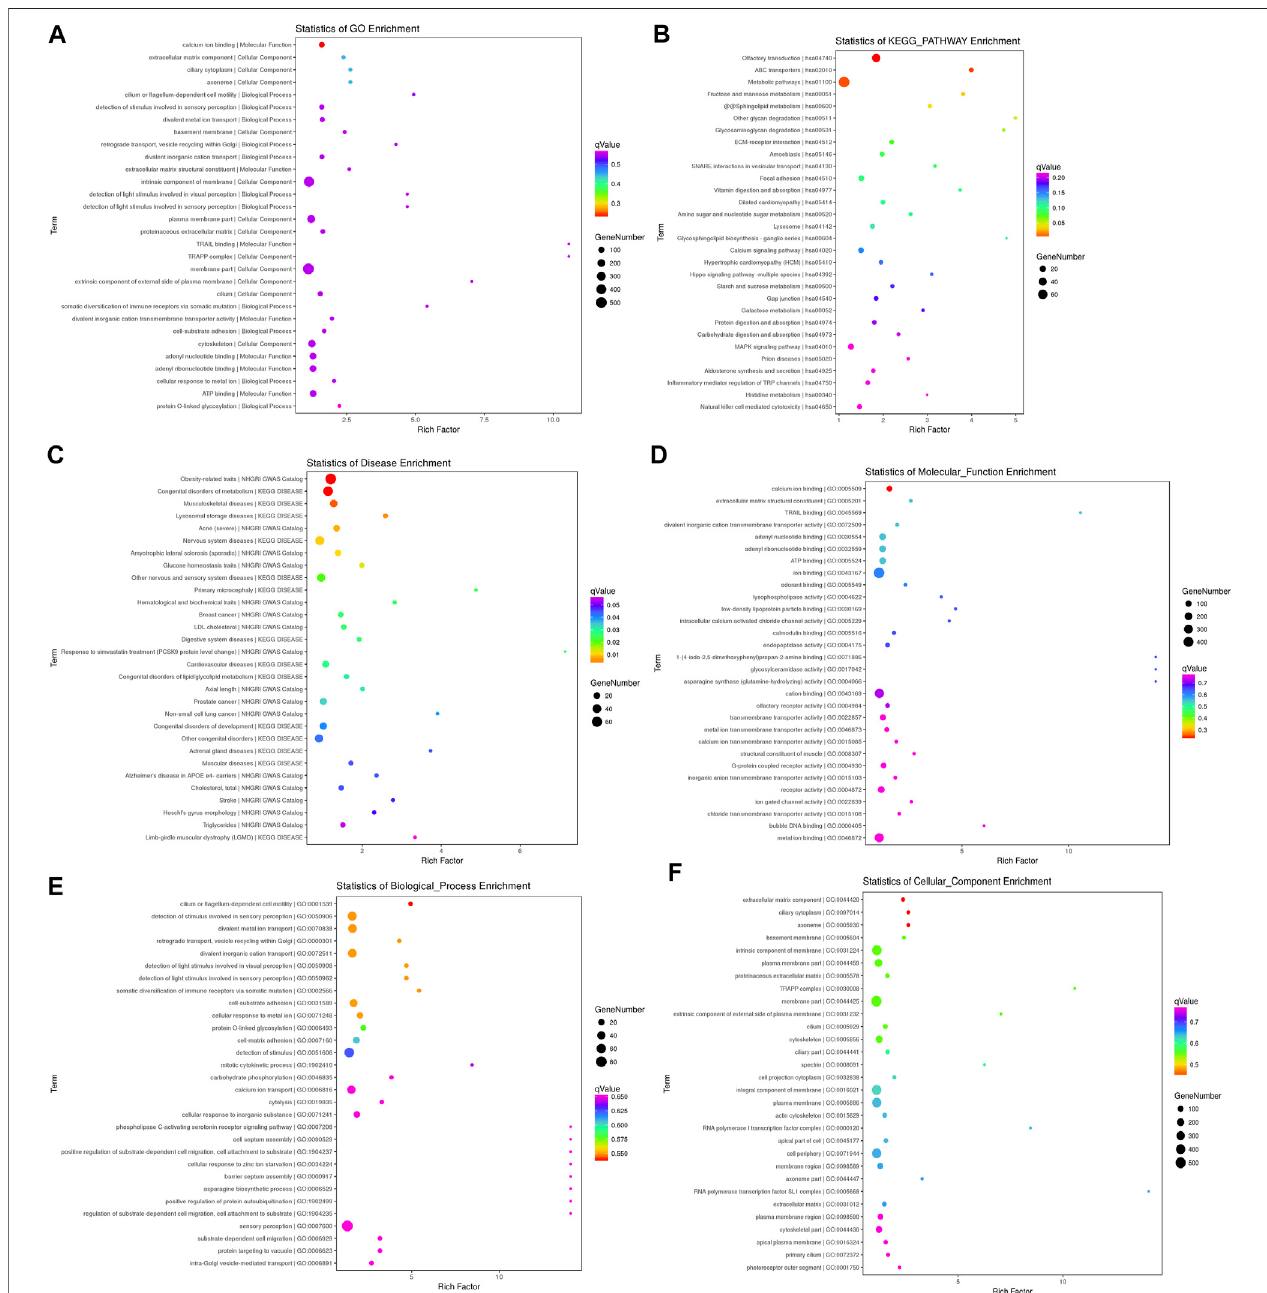
FIGURE 2 | Bubble charts. (A – C) : The top 30 q -values for functional (GO database), pathway (KEGG database), and disease enrichment. (D – F) : The top 30 q -valueGOtermsamongthecategoriesof “ cellcomponent, ”“ molecularfunction, ” and “ biologicalprocess. ” Theabscissa “ richfactor ” representstheratioofinputor background frequency inthe enrichment-analysisresult. Thebubblesizerepresentsthenumber ofgenesannotatedtothis functional entry forthe mutant gene, and the color corresponds to the q -value in the enrichment-analysis result.